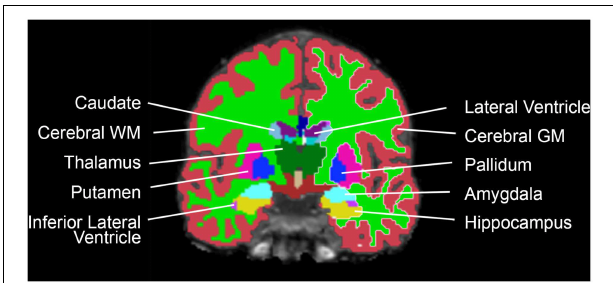
FIGURE 1 | Coronal view of one participant’s brain, with the Freesurfer segmentations